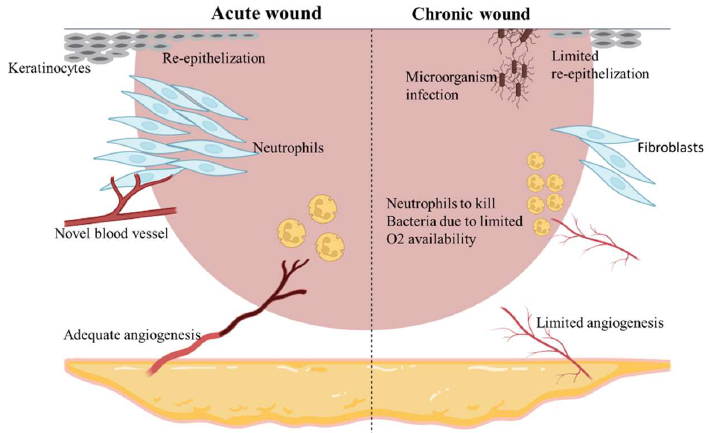
Figure 2. Processes active in acute and chronic wounds. Acute wounds (left side): Adequate angiogenesis with re-epithelialization promotion, fibroblasts’ proliferation, and neutrophils’ anti-infection activities. Chronic wounds (right side): Persistent local bacterial infections, failure formation of novel blood vessels. decreased fibroblasts’ proliferation, and the neutrophils’ anti-infection activities hampered by poor angiogenesis.